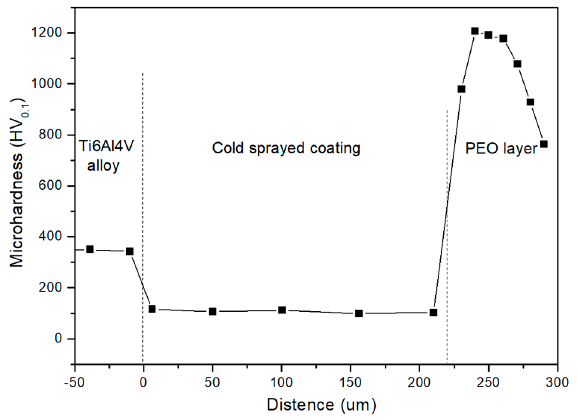
Figure 7. Cross-sectional microhardness of sample S1 as a function of the distance from the Ti6Al4V substrate/CS-coating interface.